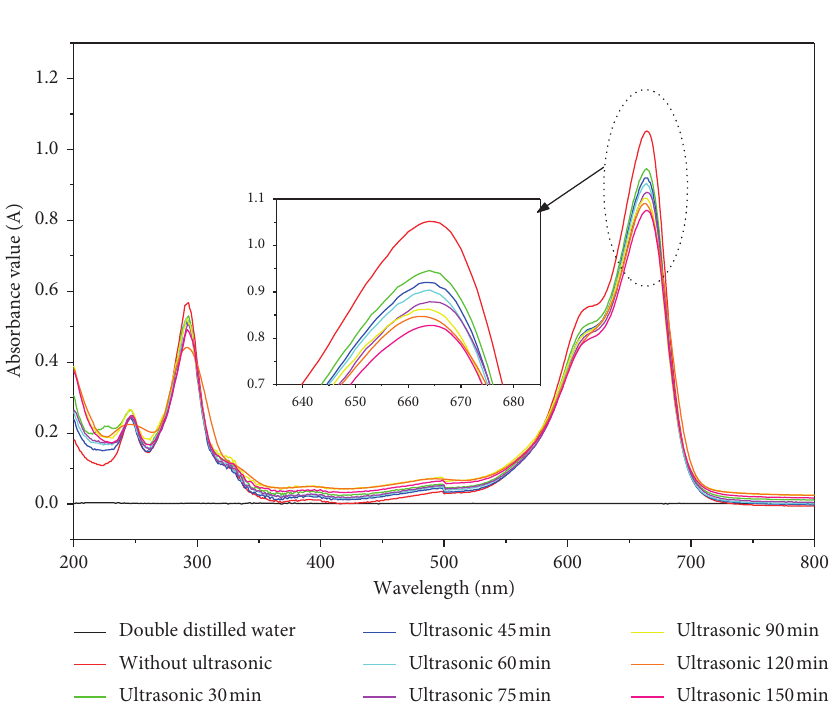
Figure 1: UV-visible spectra of methylene blue solution at different ultrasonic